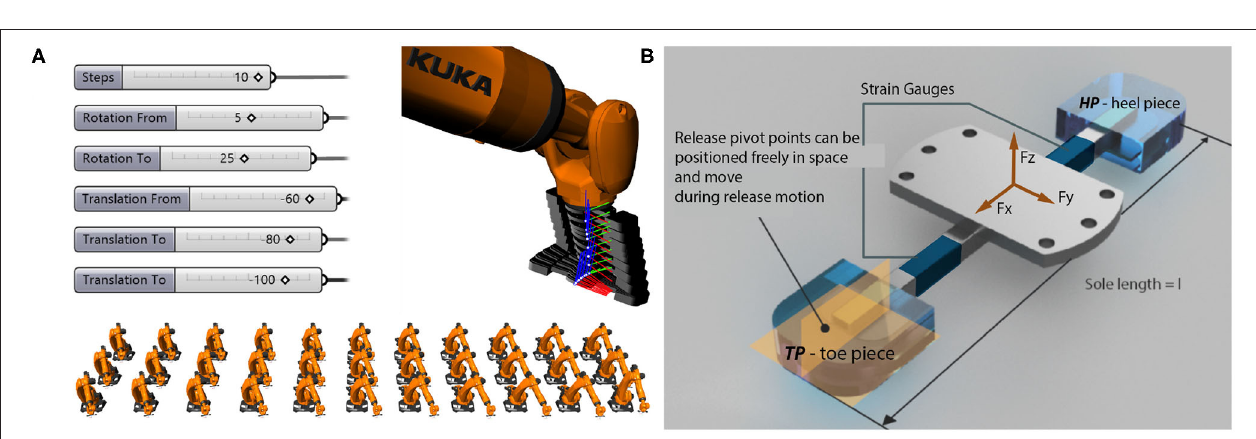
FIGURE 2 | (A) Example of robot motion sequence and software user interface: Top: Image sequence of front piece release. Bottom: Inclined back-weighted toe piece release situation. (B) Ski boot replacing device made up of a connection flange in the middle welded to a steel-square-pipe, which is equipped with strain gauges located in the x-y-plane and the x-z-plane both toward the front and the back portion.